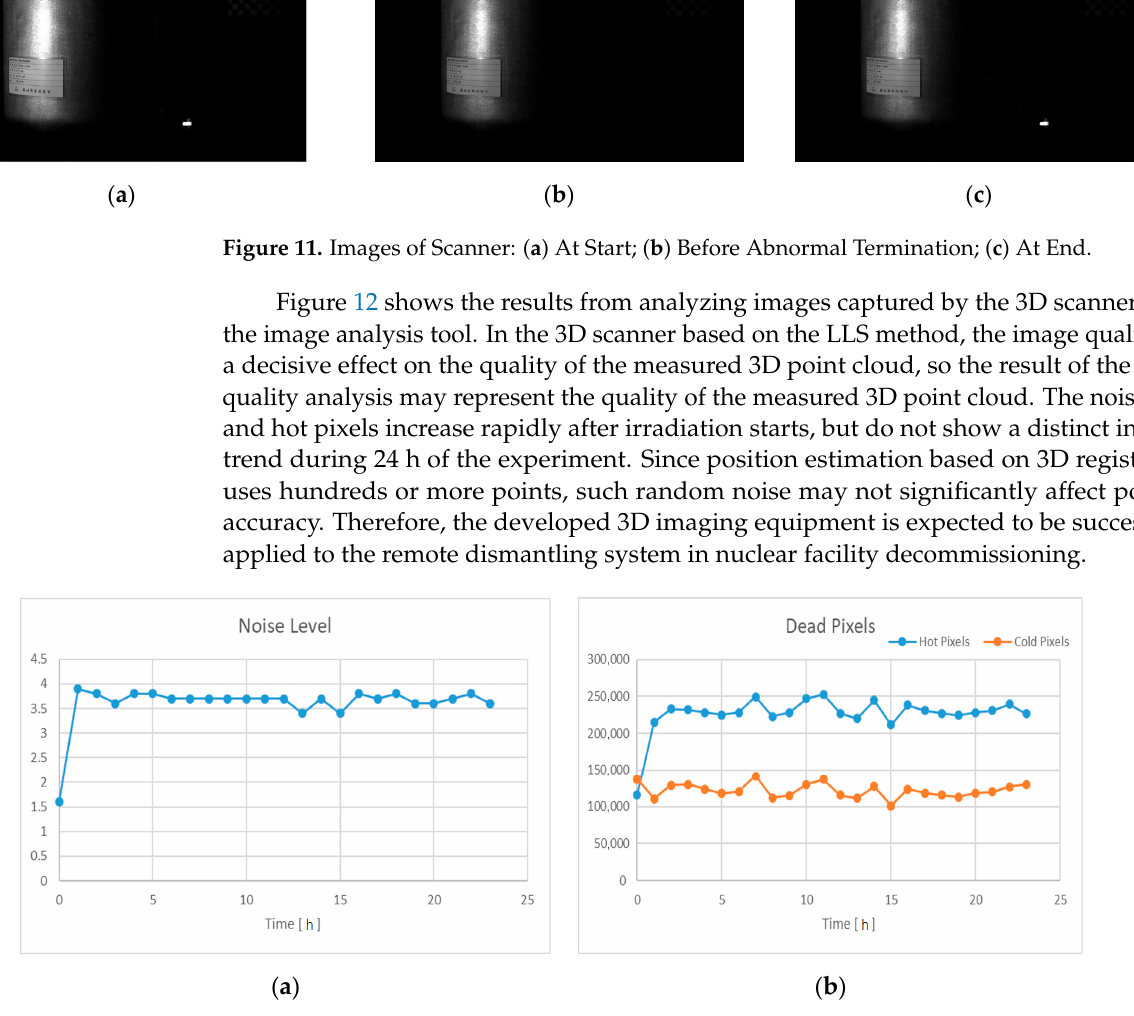
Figure 12. Image Quality Analysis: ( a ) Noise Level; ( b ) Dead